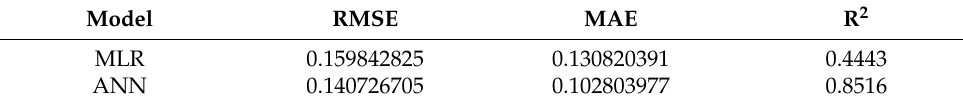
Figure 6. Comparison between experimental DO data and those obtained by neural network method ( a ) Correlation between measured and predicted DO; ( b ) Date profile of measured and predicted DO. Table 7 shows the RMSE, MAE and R 2 values of the proposed models. Table 7. RMSE, MAE and R 2 values of the MRL model and the ANN model. Model